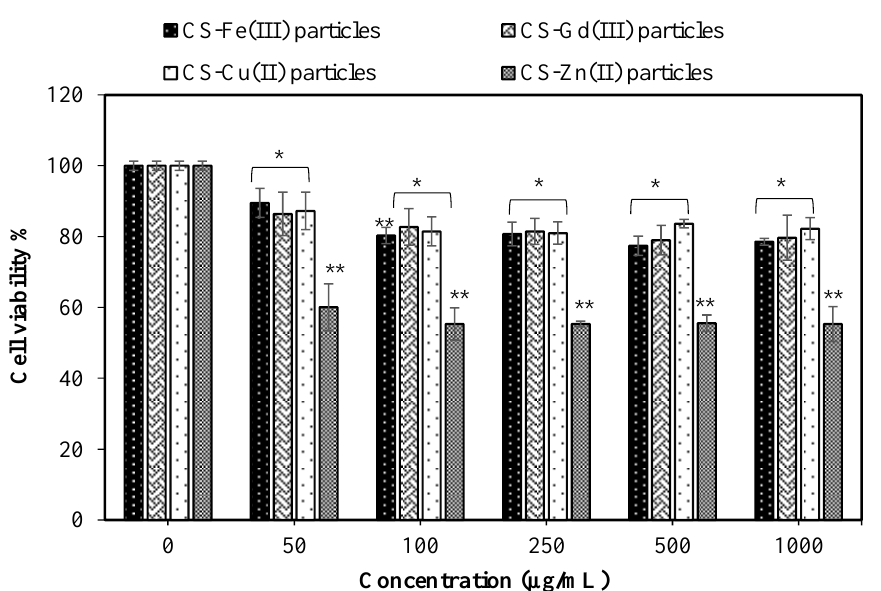
Figure 5. Cytotoxicity of CS-Fe(III), CS-Gd(III), CS-Zn(II), and CS-Cu(II) particles against L929 fibroblast cells at 24 h incubation time (Values are expressed as mean ± SD, n = 3, * p -value < 0.05, and ** p -value < 0.001 compared with control group). Table 1. Antibacterial activity of CS-Fe(III), CS-Gd(III), CS-Zn(II), and CS-Cu(II) particles by minimum inhibition concentration (MIC) values against Gram-negative Escherichia coli ATCC 8739 and Gram- positive Staphylococcus aureus ATCC 6538 for a 24 h incubation